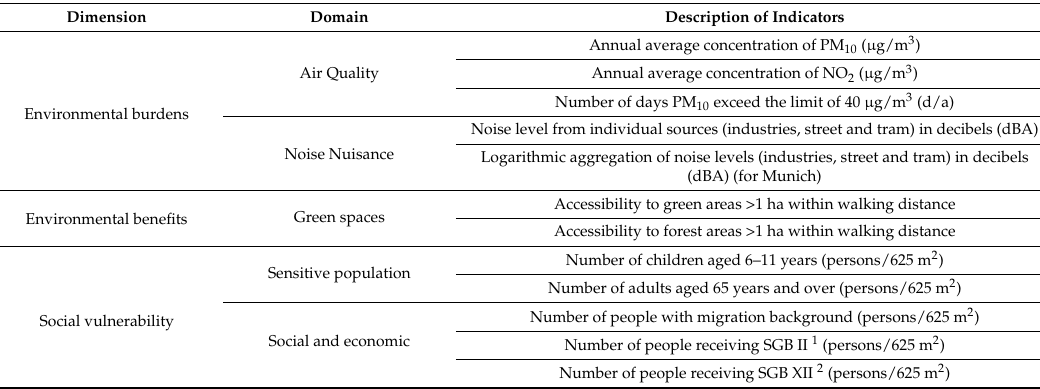
Table A1. List of indicator maps used during the